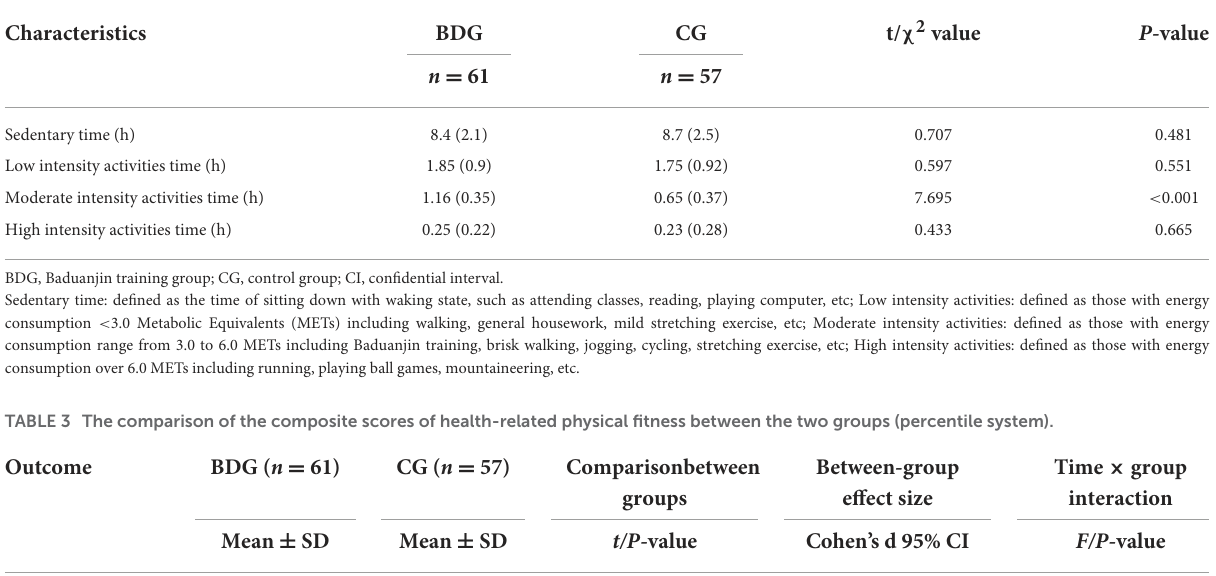
Between-group Time × group groups effect size